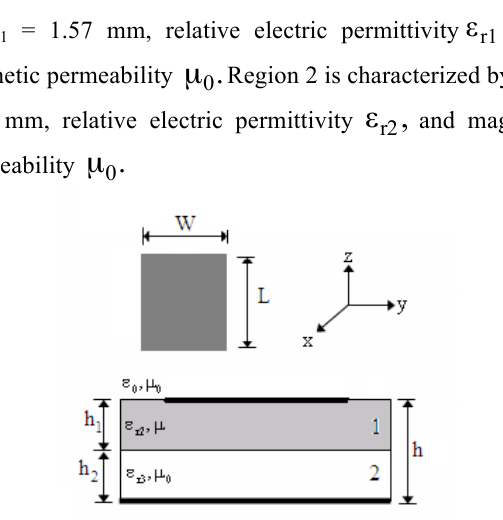
Figure 2: Rectangular patch antenna on two dielectric layers.